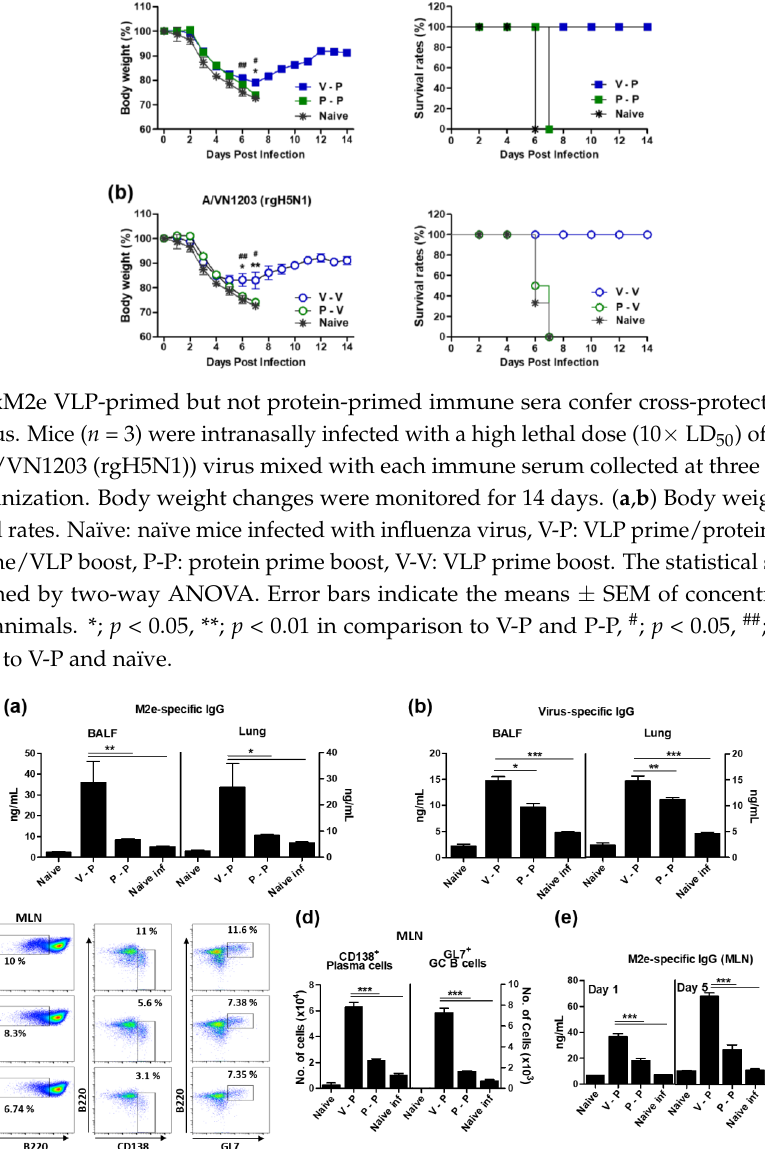
Figure 4. VLP priming is superior to protein in inducing mucosal IgG antibodies, plasma, and germinal center phenotypic B cells. Bronchoalveolar lavage fluids (BALF), lung lysates (Lung), and mediastinal lymph node (MLN) cells were collected at 6 dpi (A/Phil, H3N2). Antigen-specific IgG levels were determined in BALF and lung lysates by ELISA. ( a , b ) IgG specific to M2e peptide or virus antigens in the BALF and lung. ( c ) Representative flow cytometry profiles. The cells were gated from pre-gated mature B cells (CD19 + IgD − B220 +/− ). ( d ) CD138 + plasma and GL7 + germinal center (GC) B cells in the MLN. The cells were stained with anti-CD138 and -GL7 antibodies. ( e ) M2e-specific IgG. MLN cells were cultured in the plates coated with M2e peptide for one or five days. The groups are the same as in Figure 3. The statistical significance was confirmed by one-way ANOVA and Dunnett’s multiple comparison test. Error bars indicate the means ± SEM of concentrations from individual animals. *; p < 0.05, **; p < 0.01, ***; p < 0.001 indicate statistical significance between the groups as marked by the